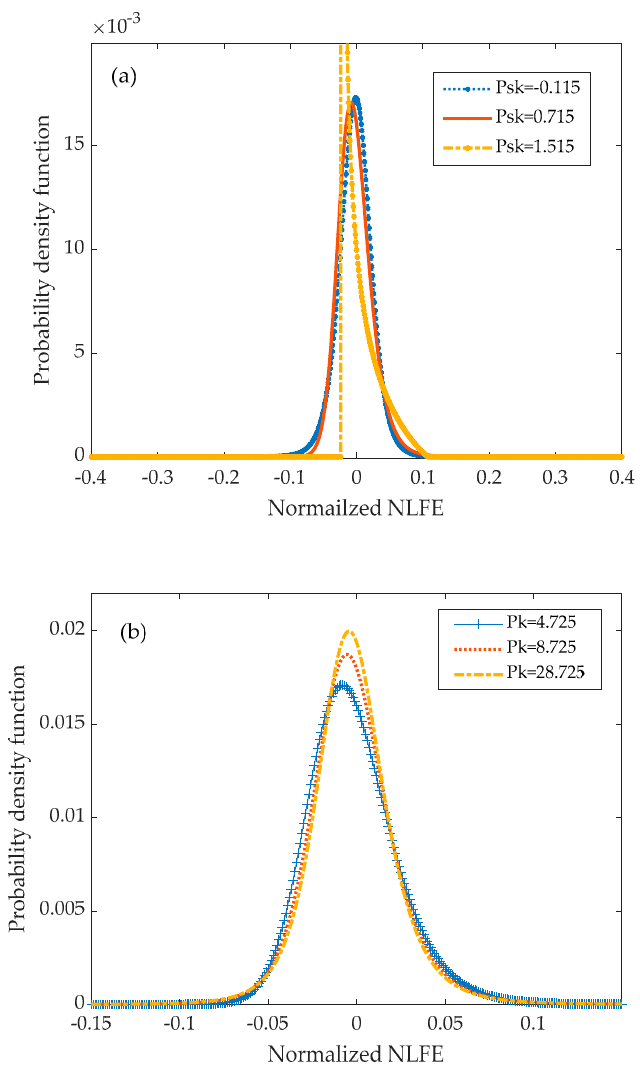
Figure 8. Probability density function of normalized NLFE: ( a ) result of changes in skewness in S5, ( b ) result of changes in kurtosis in S6. Step 5: The hourly generation schedules for every scenario, i.e., S1 to S10, are